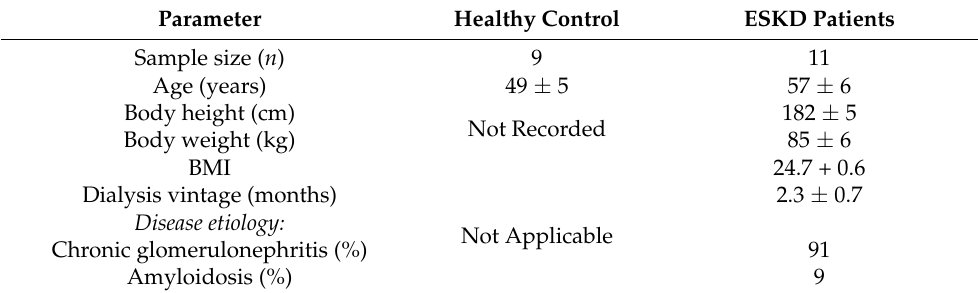
Table 1. Demographics of healthy control and ESRD patients used in this